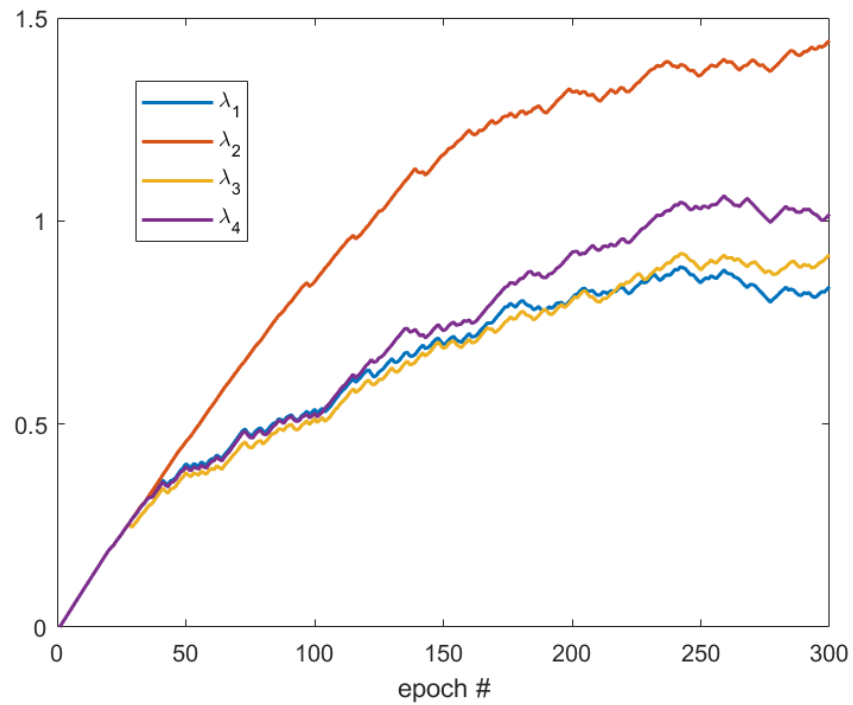
Figure 5. Development of weights of different